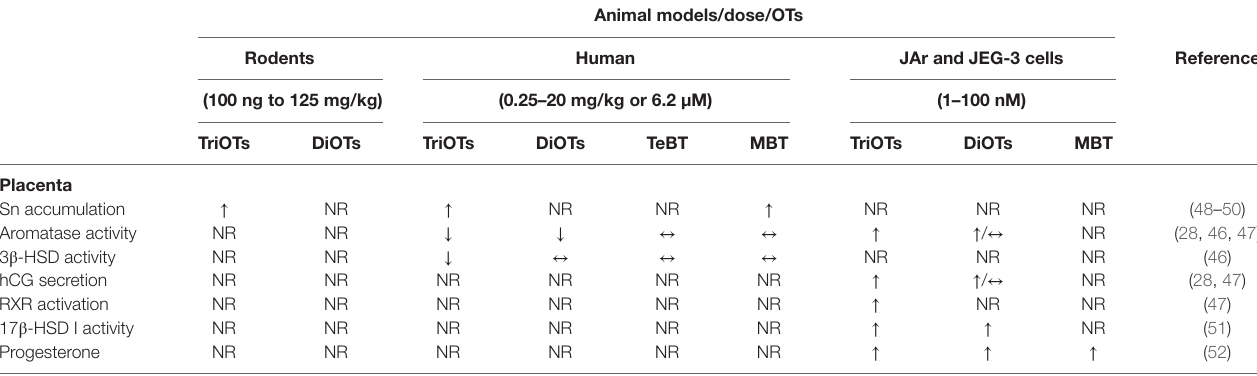
TAble 2 | Summary of placental changes induced by